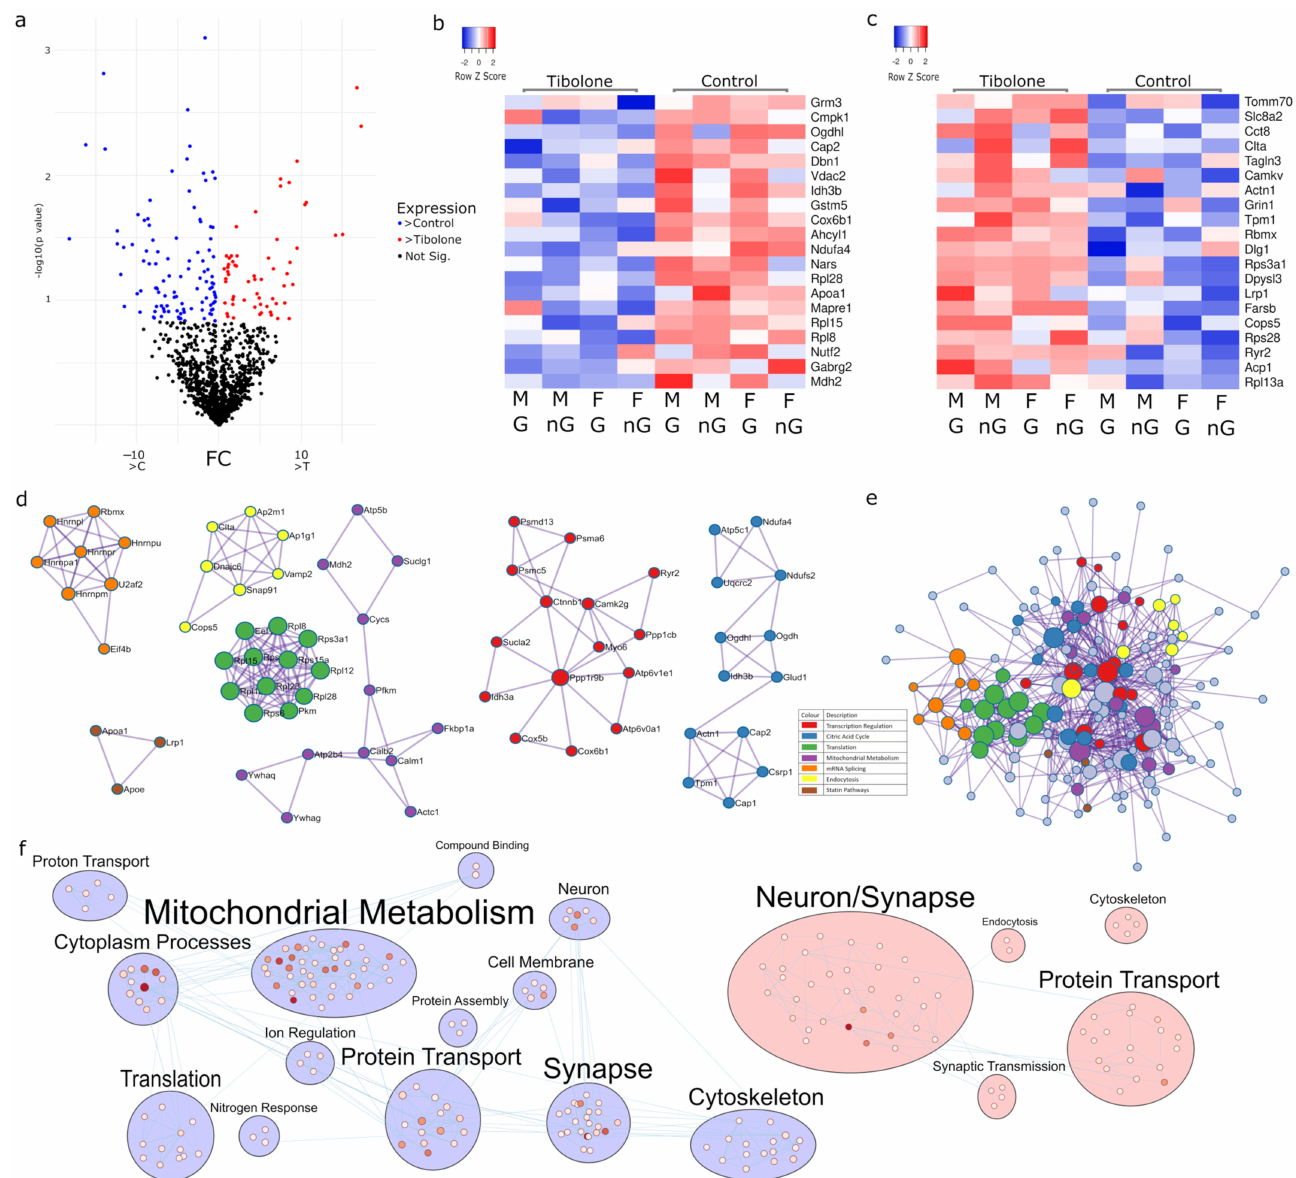
Figure 3. Hormone-regulated proteins in the prefrontal cortex of mice. A single Tibolone treatment produced the greatest number of differentially expressed proteins ( a ). The top 20 proteins expressed in the control ( b ) and in Tibolone ( c ) are shown in heatmaps. The first MCODE-driven PPI analysis ( d ) revealed SRP-dependent cotranslational protein targeting to the membrane (green, p = 7.94 × 10 − 23 ), Nonsense-Mediated Decay (NMD) independent of the Exon Junction Complex (EJC) (green, p = 1 × 10 − 22 ), the formation of a pool of free 40S subunits (green, p = 2.5 × 10 − 22 ), mRNA splicing (orange, p = 2 × 10 − 14 ), the citric acid (TCA) cycle and respiratory electron transport (blue, p = 5 × 10 − 10 ) and clathrin-mediated endocytosis (yellow, p = 2.5 × 10 − 10 ) to be the most impacted functions upon Tibolone treatment. When PPI analysis was performed on all proteins in one network ( e ), generation of precursor metabolites and energy ( p = 1.26 × 10 − 12 ) and Alzheimer’s disease ( p = 5.01 × 10 − 12 ) were the most enriched functions. When all of the significantly enriched functions were mapped into clusters ( f ), we can see a large number of mitochondrial metabolism functions being more prevalent in the control group (blue), whilst neuronal and synapse-associated functions are more upregulated upon Tibolone